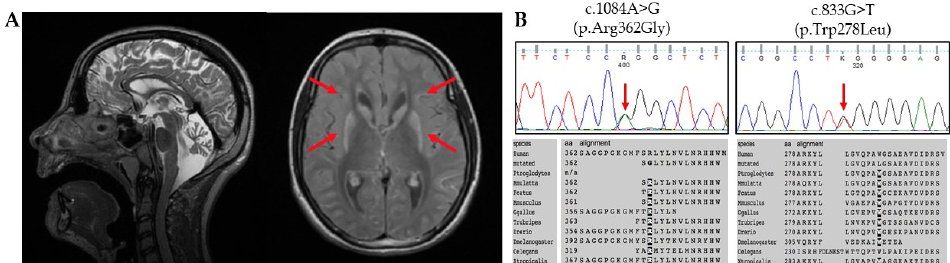
Figure 1. ( A ) Brain MRI of patient NG2880. Sagittal T2-weighted image (left panel) showing global cerebellar atrophy and thin corpus callosum; axial T1-weighted image (right panel) showing hyperintensity and hypotrophy of caudate nuclei and putamen. ( B ) Electropherograms showing the two identified variants and conservation across species.